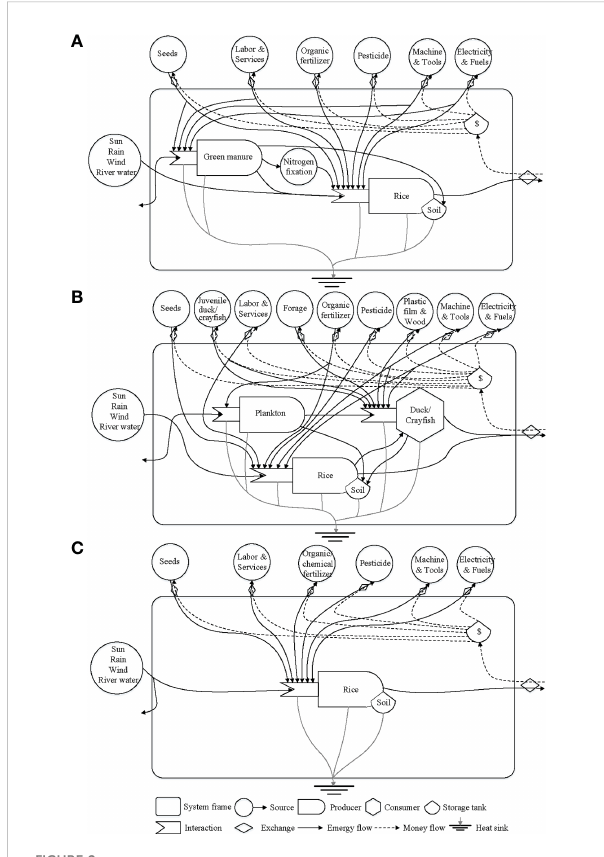
FIGURE 2 Aggregated energy fl ow diagrams of rice-green manure rotation (A) , rice-duck/cray fi sh co-culture (B) and organic/conventional rice monoculture (C)